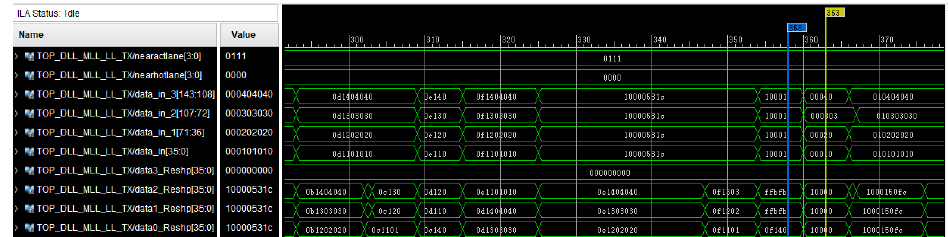
Figure 11. The ILA waveforms of hierarchical error recovery. ( a ) Far end; ( b ) near end.